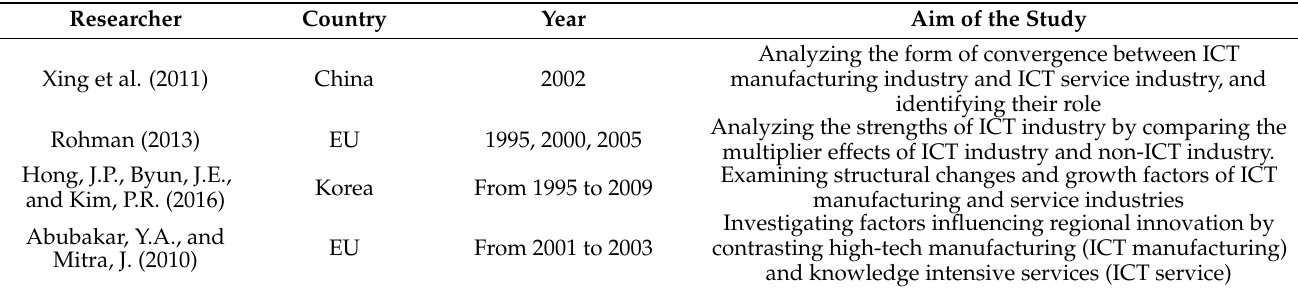
Table 5. Research on ICT industry divided into manufacturing and service sectors.